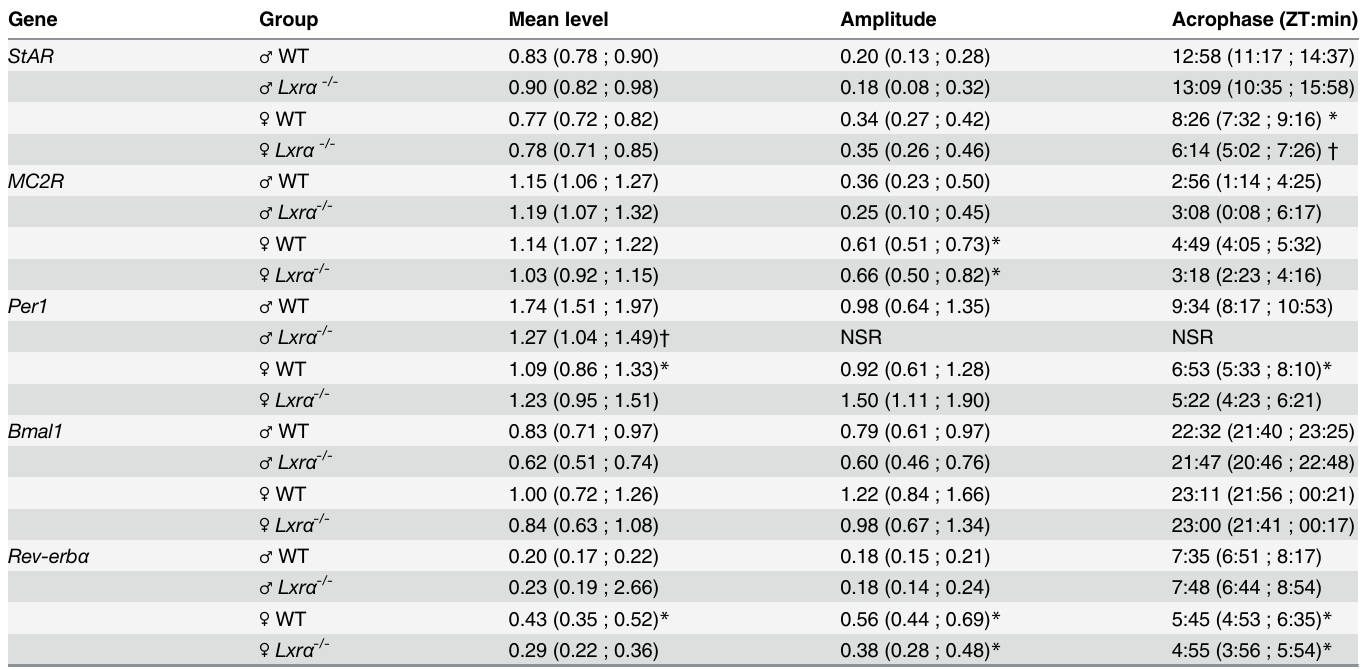
For each parameter measured, values are represented as median ± 95% bootstrap con fi dence intervals. * indicates signi fi cant differences between females vs males † indicates signi fi cant differences between Lxr α -/- vs WT